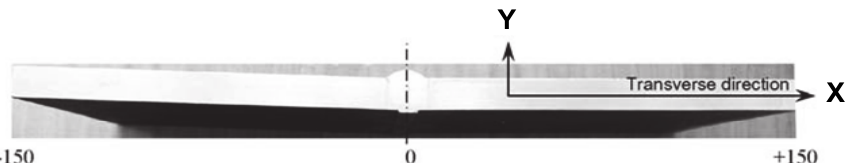
Figure 3: An example of a multi-pass welded plate.